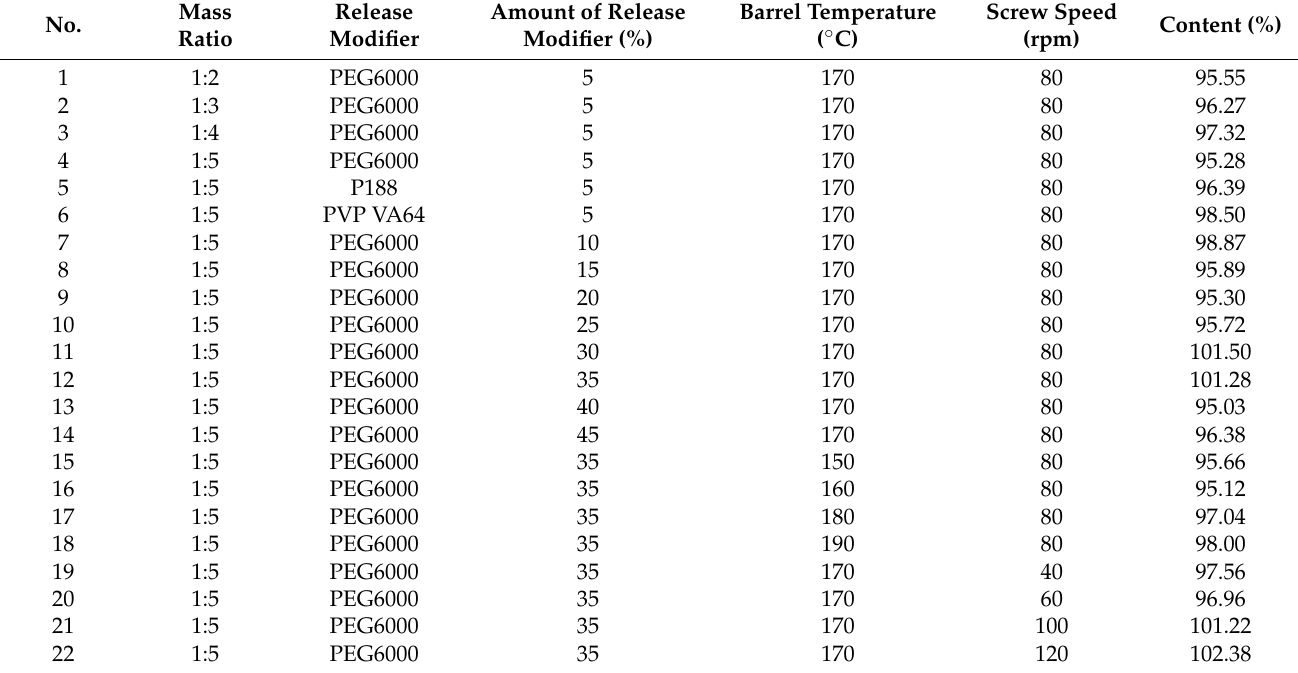
Table 3. Univariate analysis of